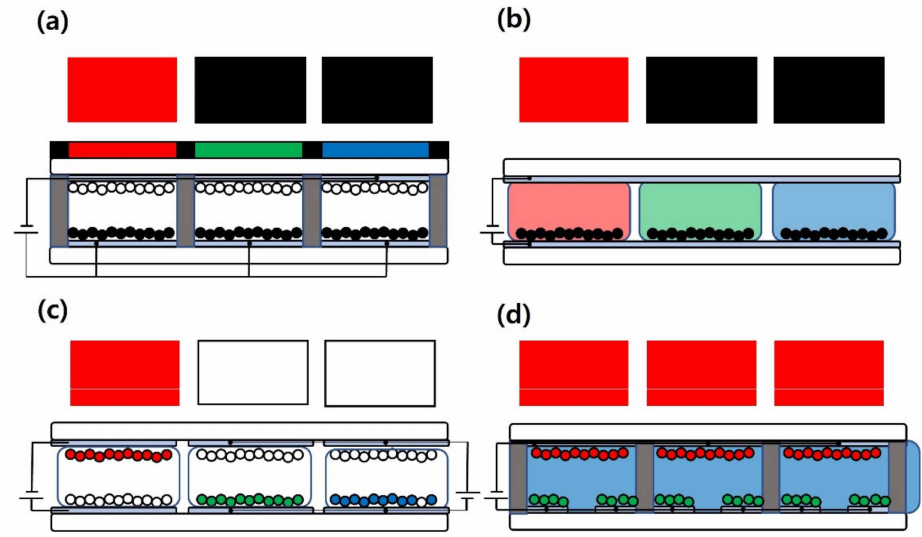
Figure 1. Various device structures of E-papers: ( a ) color filter structure, ( b ) color dye structure, ( c ) color particle structure, and ( d ) multi-electrode